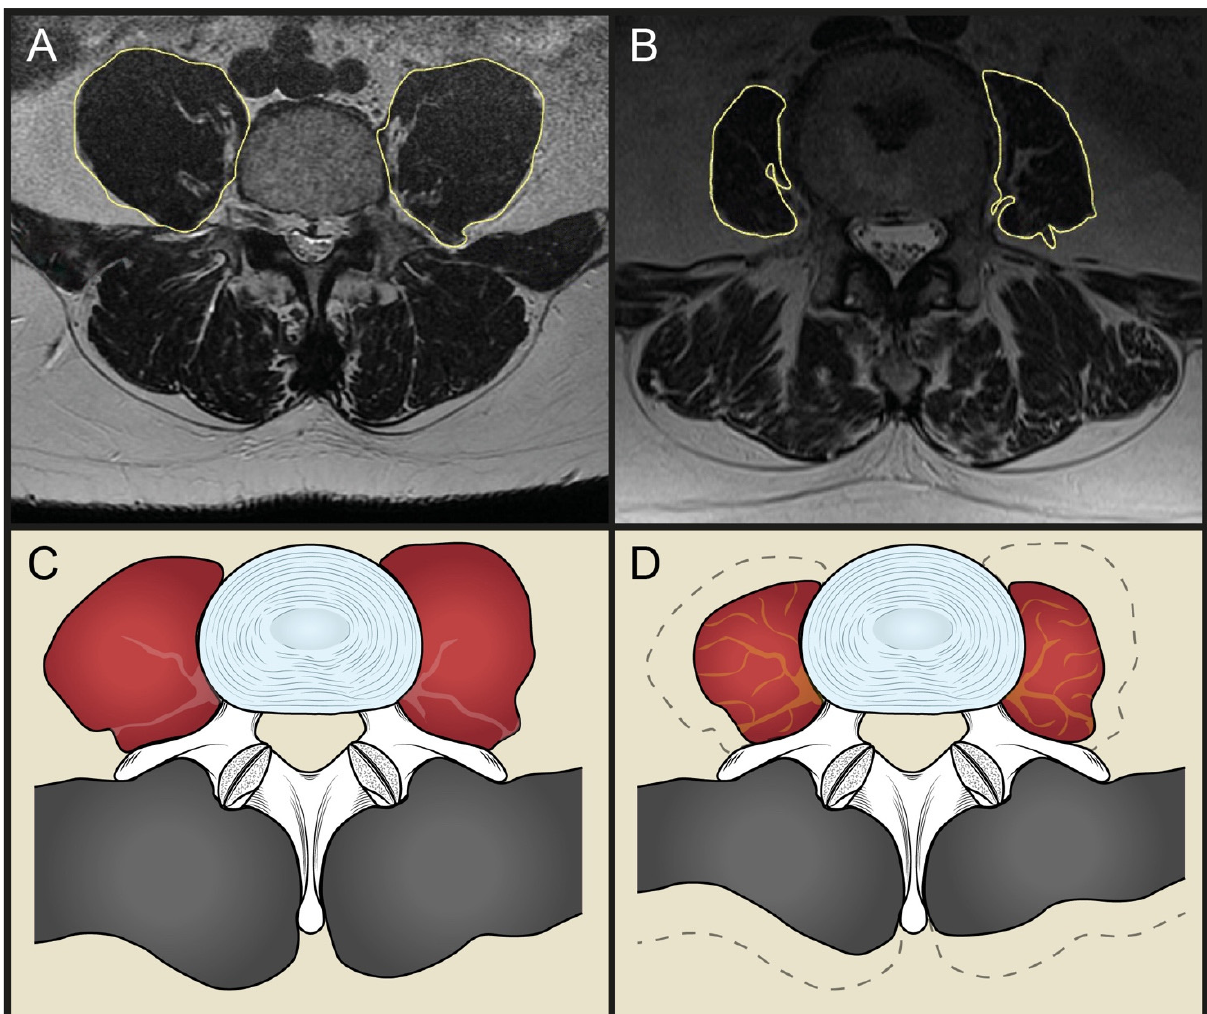
Figure 2. Examples of high (left) and low (right) PLVIs. ( A ) Example of high PLVI values in an MRI of the spine in axial view; ( B ) example of low PLVI values in an MRI of the spine in axial view; ( C ) example drawing of a non-sarcopenic psoas muscle (high PLVI); ( D ) example drawing of a sarcopenic psoas muscle (low PLVI).